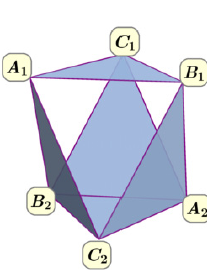
Figure 11: The simplicial complex of ai-expressible sets for the Spiral inflation of the Triangle scenario (Fig.3). The 5 facets correspond to the maximal ai-expressible sets, namely { A 1 B 1 C 1 } , { A 1 B 2 C 2 } , { A 2 B 1 C 2 } , { A 2 B 2 C 1 } and { A 2 B 2 C 2 }